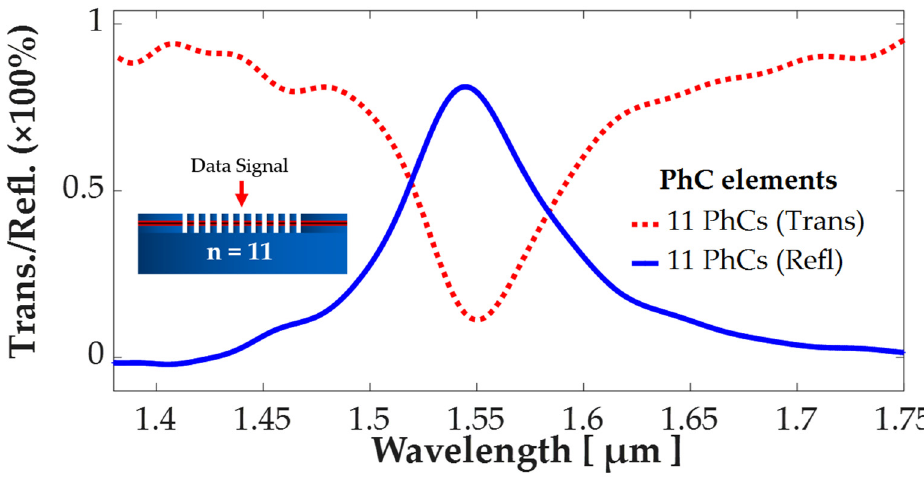
Figure 4. Transmission and reflection spectra of an 11 PhCs-based structure.